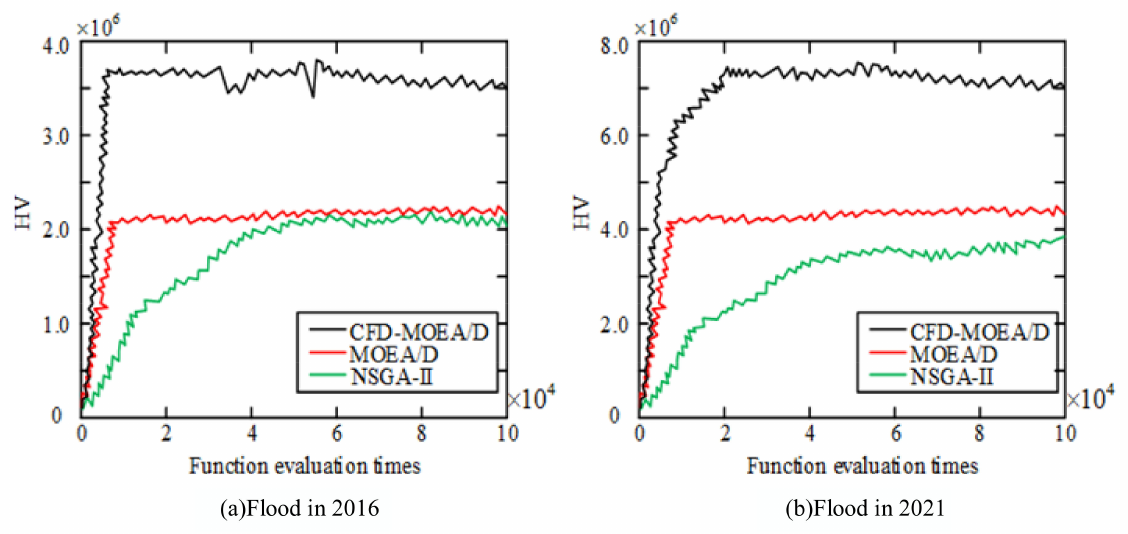
Figure 6. Comparison of HV curves of three algorithms in flood regulation in 2016 and 2021.